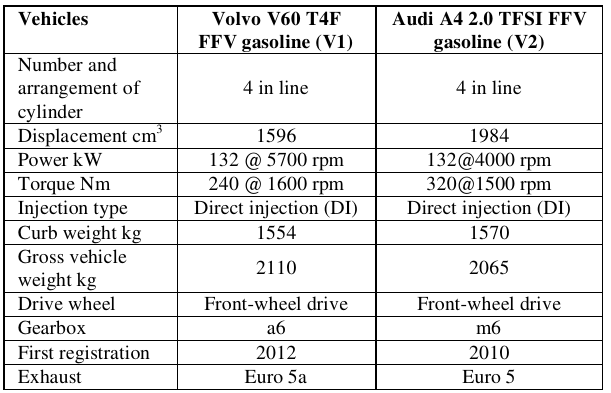
Table 2. Data of tested